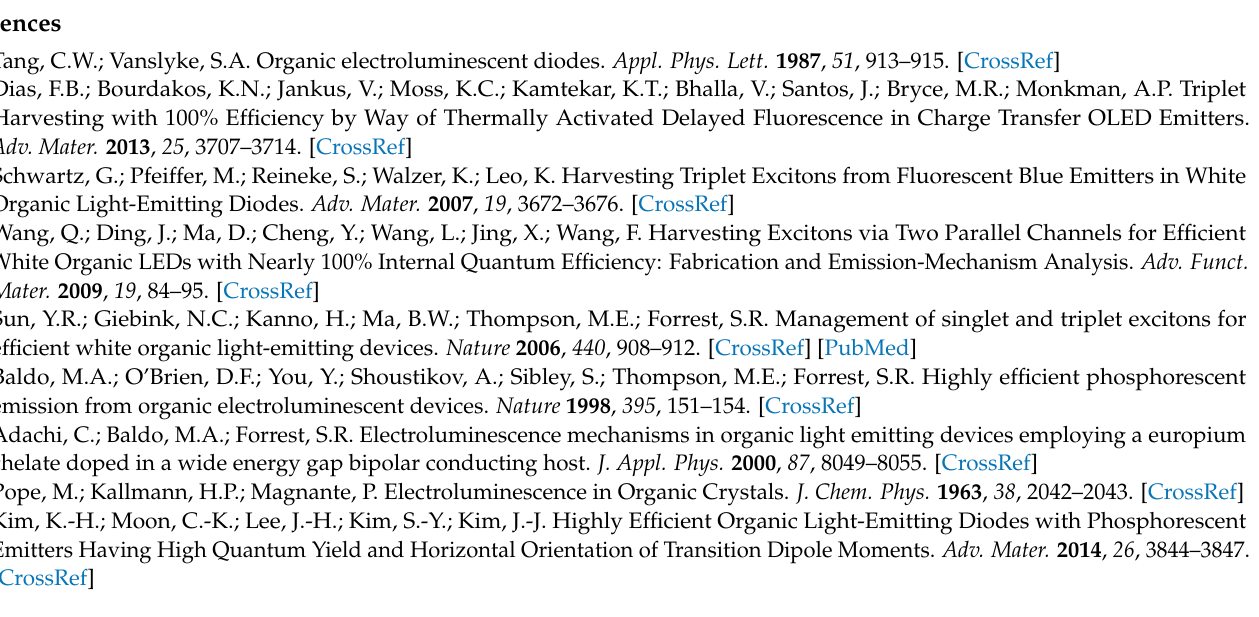
neat films. Figure S7: PL spectra of 12 wt% (a) ICzCN and (b) ICzCYP doped films in PPF host. Figure S8: Streak images and time-resolved PL spectra of 12 wt% (a) ICzCN :PPF and (b) ICzCYP :PPF co-deposited films. Table S2: Photophysical properties of ICzCN and ICzCYP in solution, neat film and 12 wt% doped film in PPF host